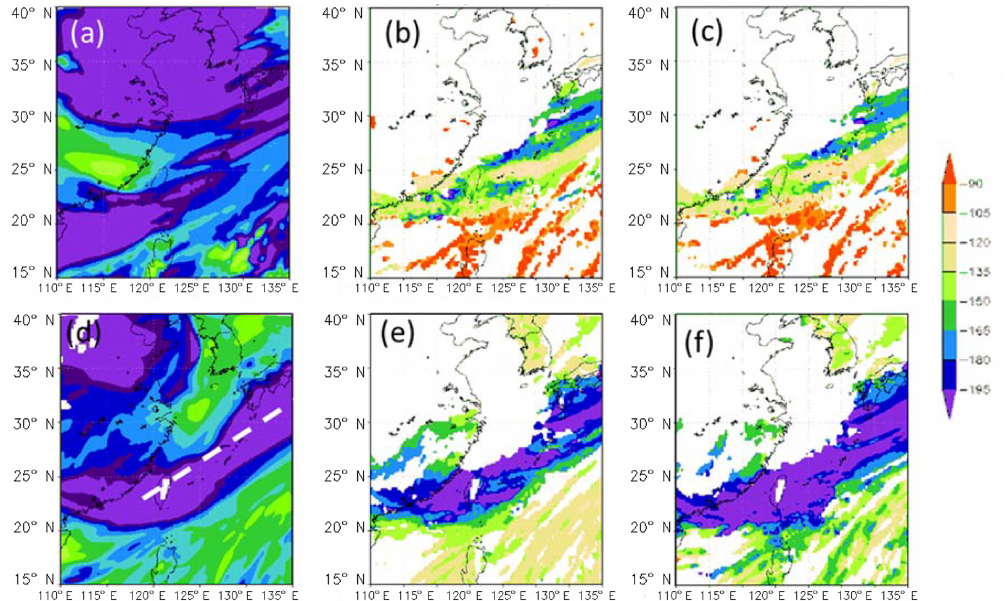
Figure 8. Simulated δ D (in ‰) of water vapor (a, d) , liquid-phase condensates including cloud and rainwater (b, e) , and ice-phase conden- sates, including cloud 697 ice, snow, and graupel (c, f) in the CTRL run at 500hPa (a, c) and 850hPa (d, f) on 12 June